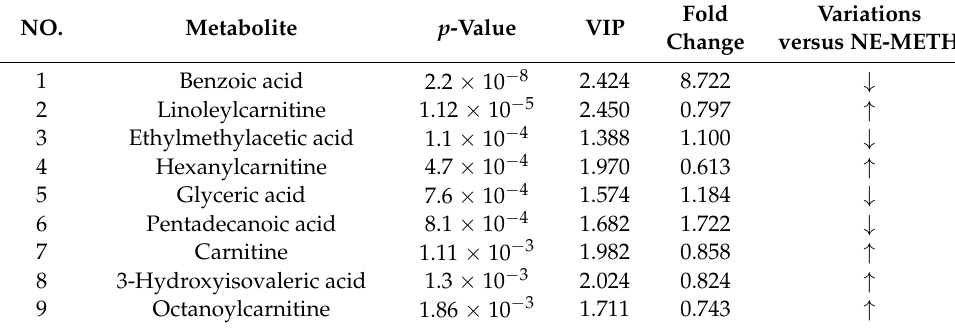
Figure 3. Differential metabolic profiles between the NE-METH and E-METH groups. ( A ) PCA score plot data of the NE-METH group (yellow) versus the E-METH group (green), ( B ) OPLS-DA score plot data of the NE-METH group (yellow) versus the E-METH group (green), ( C ) permutation plot of the OPLS-DA models, ( D ) volcano plot of 55 significantly altered metabolites ( p < 0.05), and ( E ) bubble plot of altered metabolic pathways analysis obtained via KEGG analysis and the comparison of E-METH with NE-METH. Table 2. Differential metabolites screened from the E-METH and NE-METH